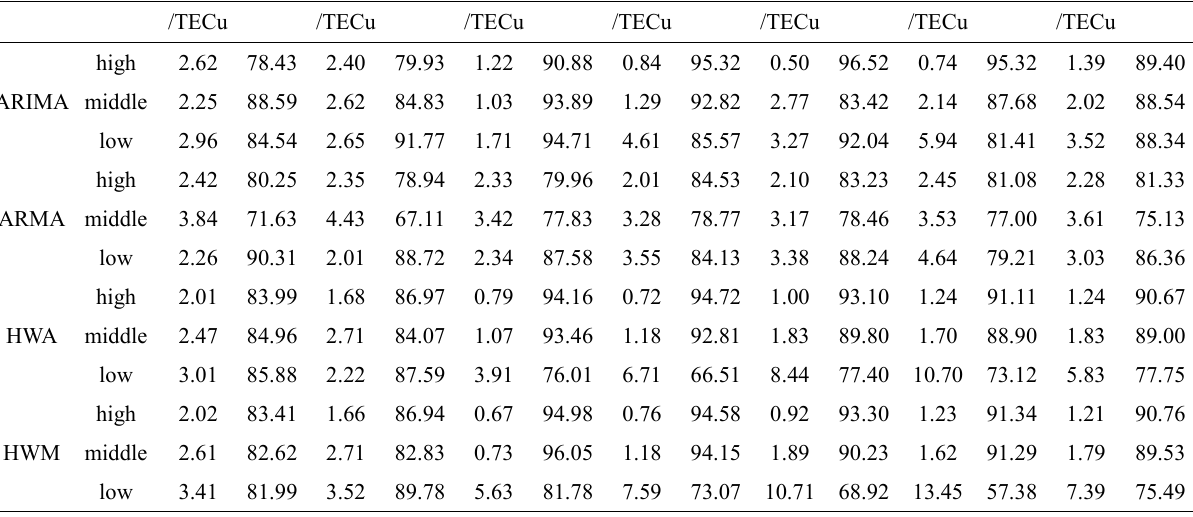
Table 4. RMS and relative accuracy in ionospheric active